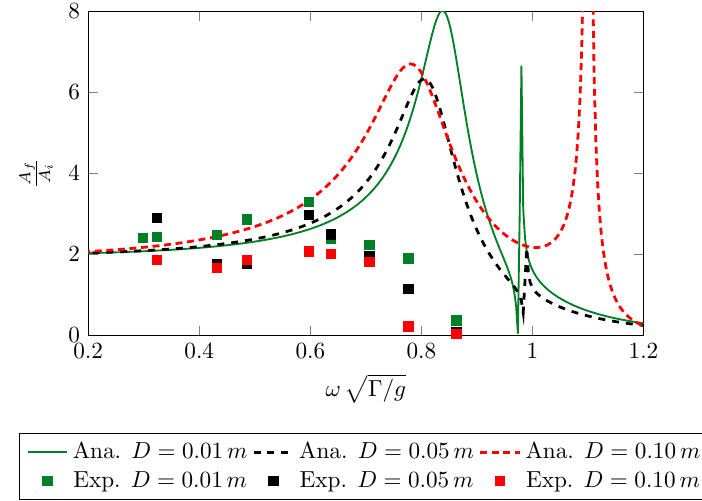
Figure 7. Impact of the toe clearance on the floater motion for floater 5 at h = 0.6 m for D = 0.01 m, D = 0.05 m and D = 0.10